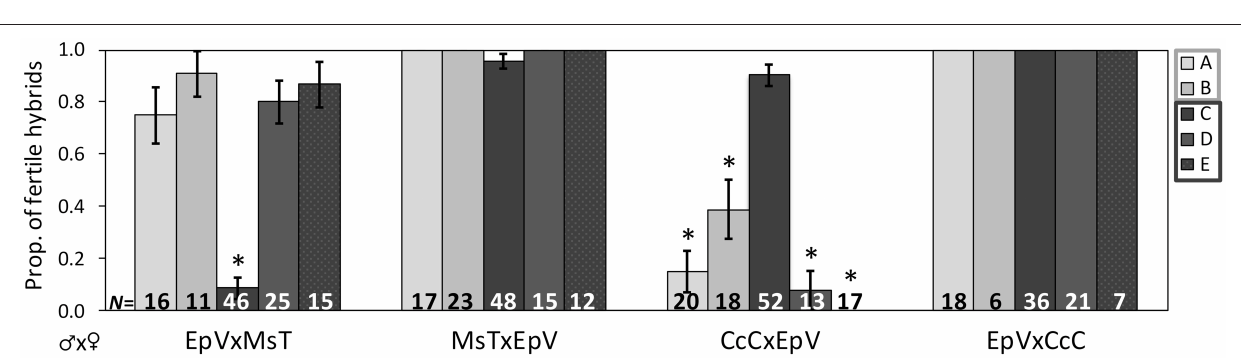
FIGURE 1 | Proportion of F 1 hybrids resulting from crosses between host-foodplant complex sources of Cotesia congregata that produced progeny. Three letter abbreviations denote wasp host species and host-foodplant. All F 1 broods were reared on Manduca sexta. Uncommon wasp sources (A) SkP ( Sphinx kalmiae on privet) and (B) DhP ( Dolba hyloeus on pawpaw) were crossed with two abundant incipient species, MsT ( Manduca sexta on tobacco) and CcC ( Ceratomia catalpae on catalpa). Crosses with a significant reduction in fertile hybrids are marked with *(Fisher’s exact test: p < 0.001); sample sizes are at the base.